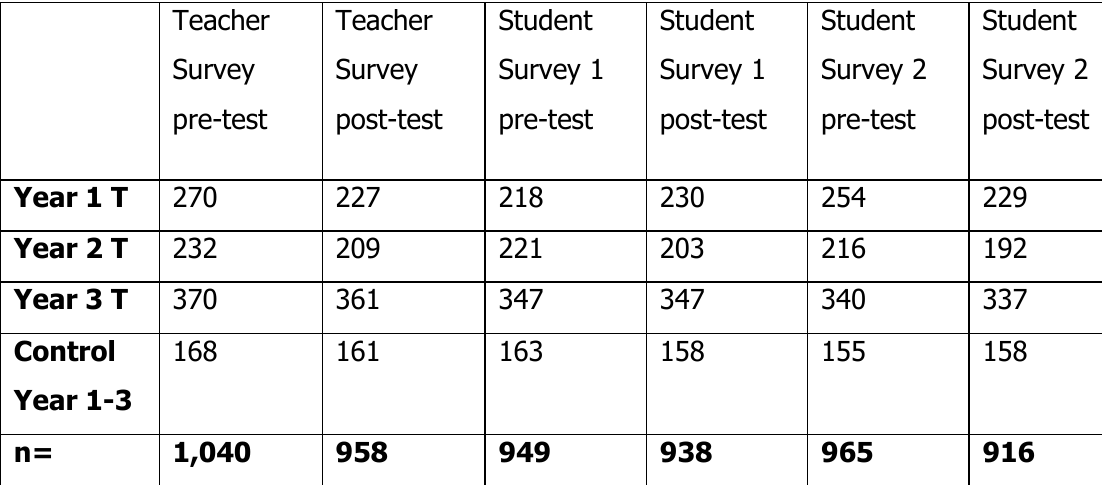
Survey Responses by Type and